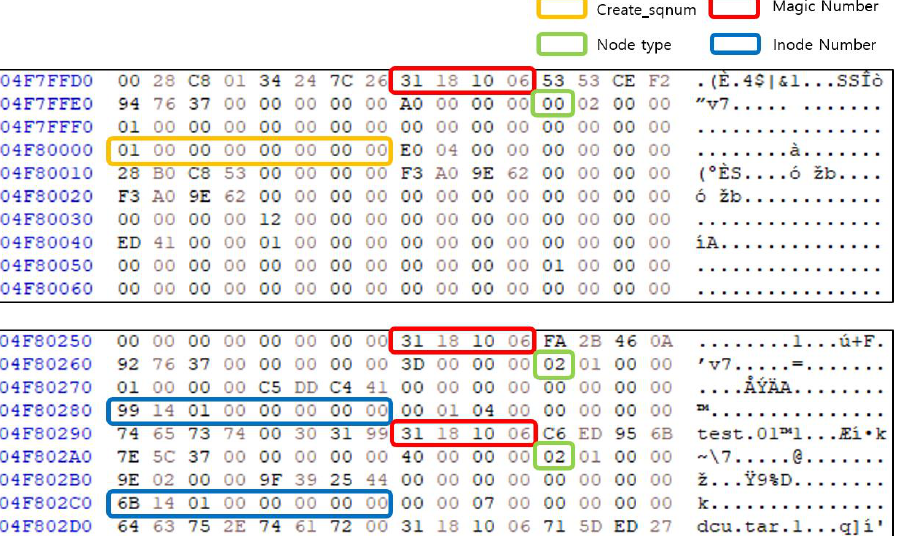
Figure 20. UBIFS directory of entry ( top )/inode ( bottom ).